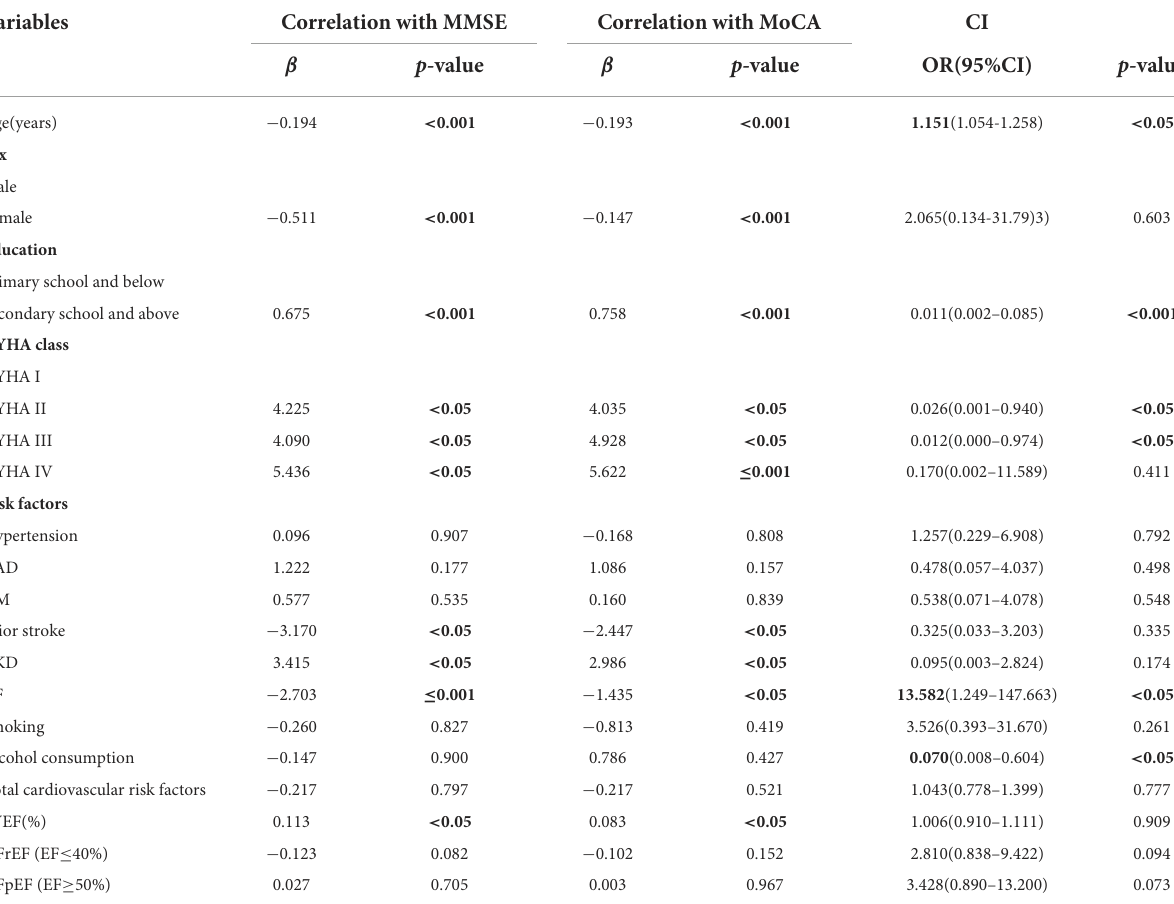
TABLE 2 Association between MMSE, MoCA and